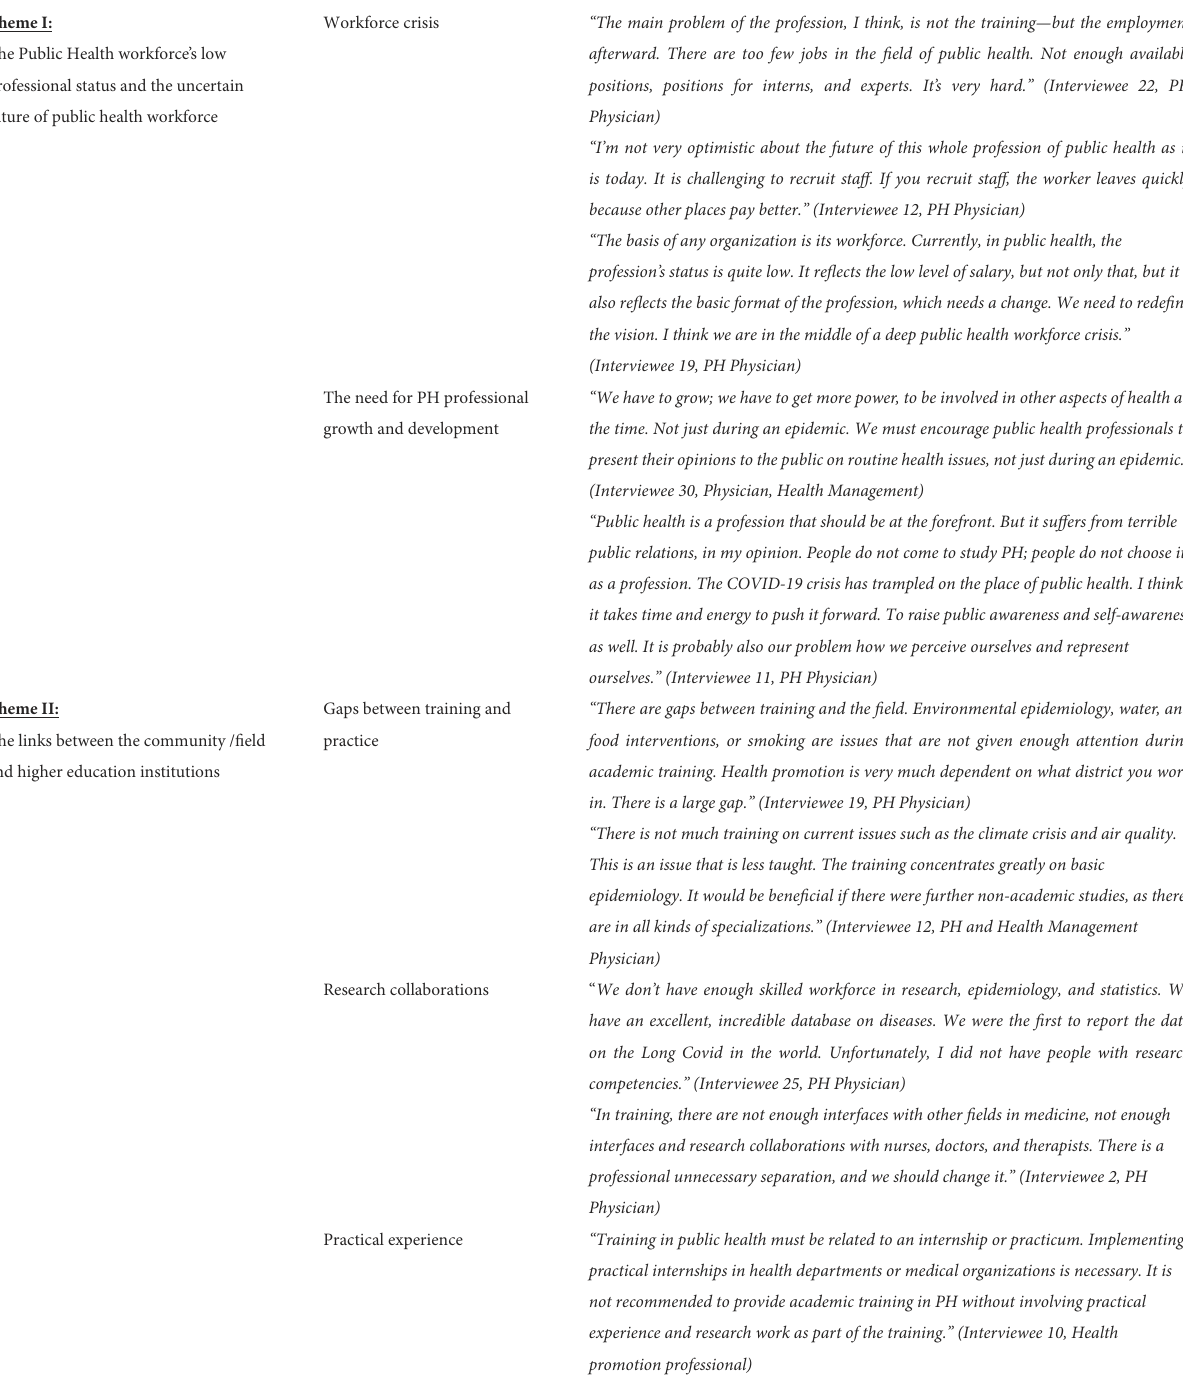
TABLE 1 Themes, categories, and quotes related to public health